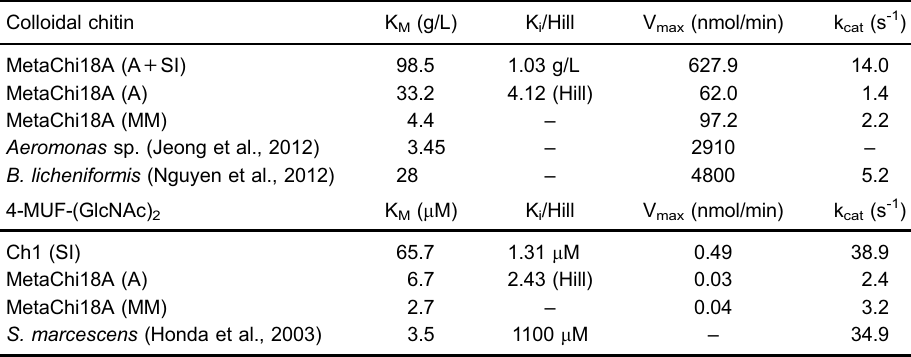
Figure 6. Kinetic behavior of MetaChi18A. A , Colloidal chitin as substrate; B , 4-MUF-(GlcNAc) 2 as substrate. Colloidal chitin (g/L) and V 0 (nmol of reducing sugar/min); 4-MUF-(GlcNAc) 2 ( m M) and V 0 (nmol of MUF/min). Reactions were performed at 25 mM sodium acetate buffer, pH 5, at 50°C ( A ) or 37°C ( B ). The black line is the model that better fi ts the data: ( A ) allosteric kinetic + substrate inhibition, and ( B ) substrate inhibition; Blue dotted line: allosteric kinetic; Orange slashed line: Michaelis-Menten kinetic. Table 2. Kinetic parameters of MetaChi18A and GH-18 chitinases on 4-MUF-(GlcNAc) 2 and colloidal chitin. Colloidal